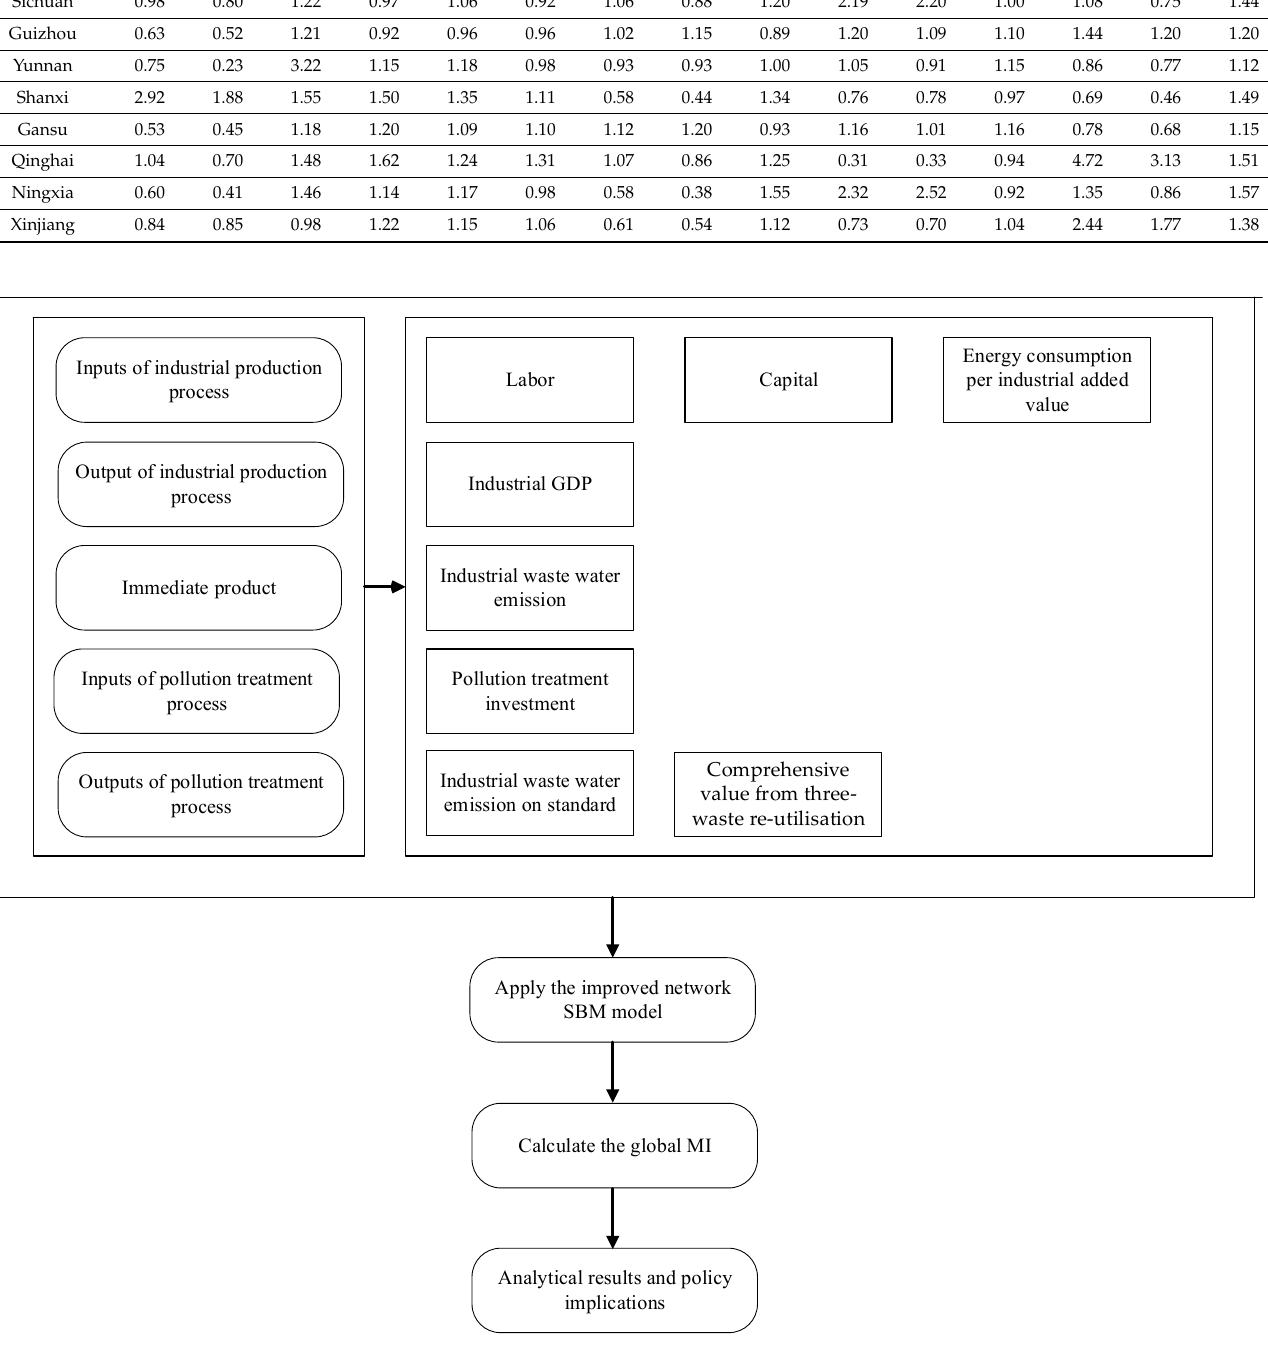
Figure A1. Graphical illustration of the current paper.